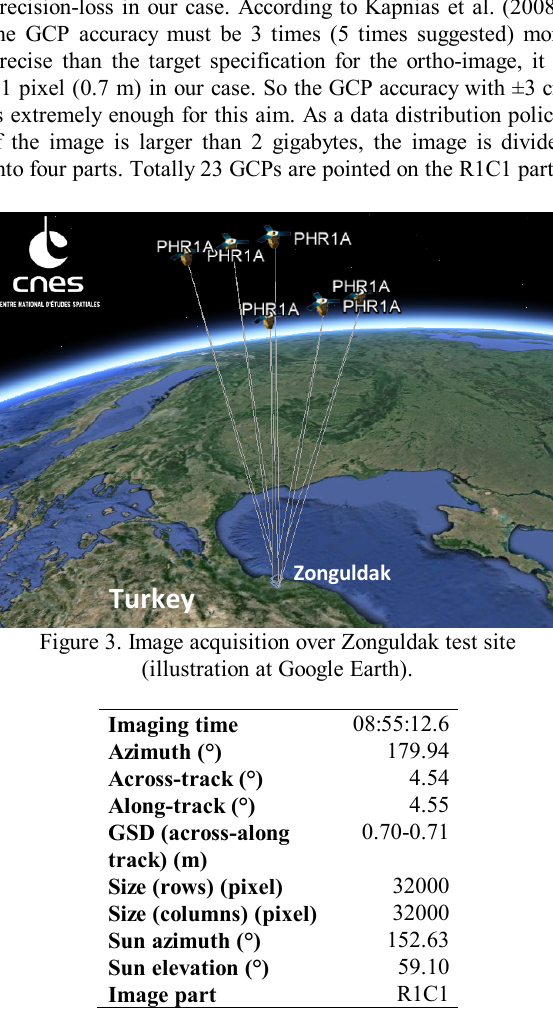
Table 1. Main characteristics of the investigated